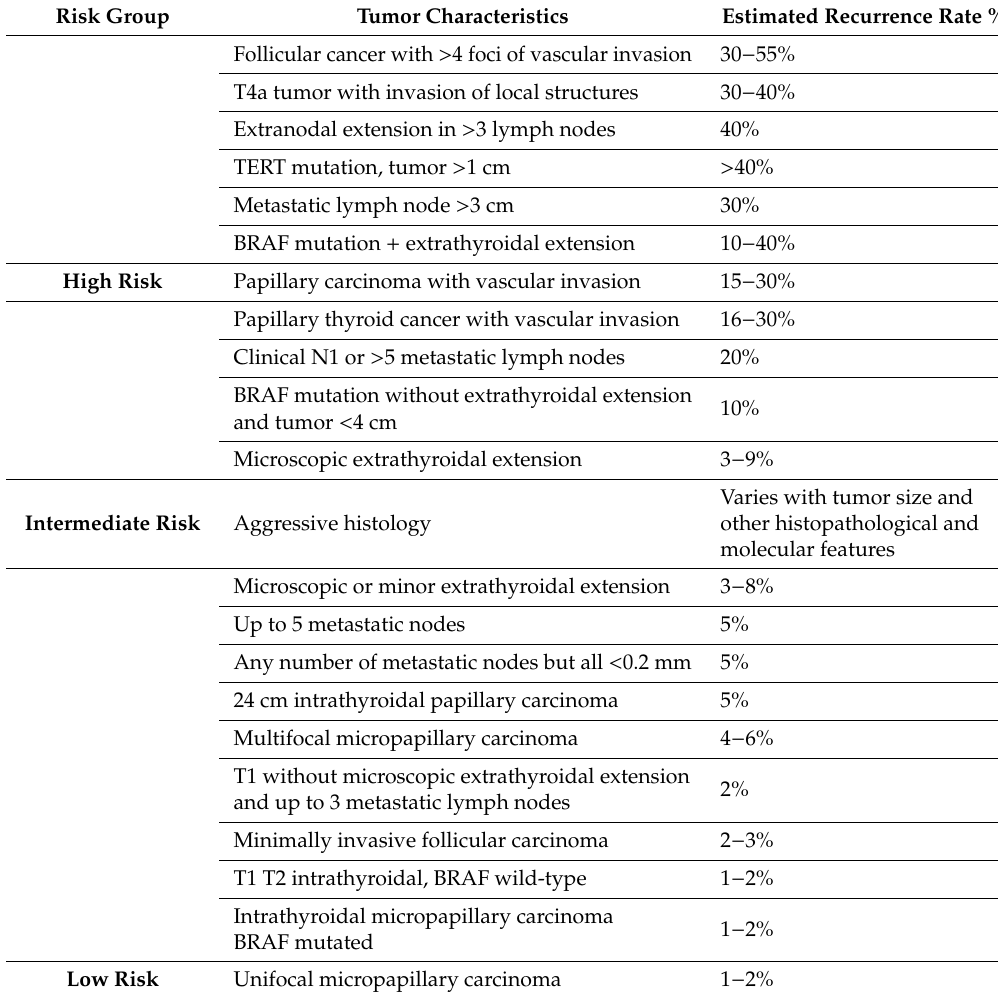
Table 1. Risk groups according to the 2015 American Thyroid Association (ATA) Guidelines [1]. Risk of structural disease recurrence in patients without structural disease after initial